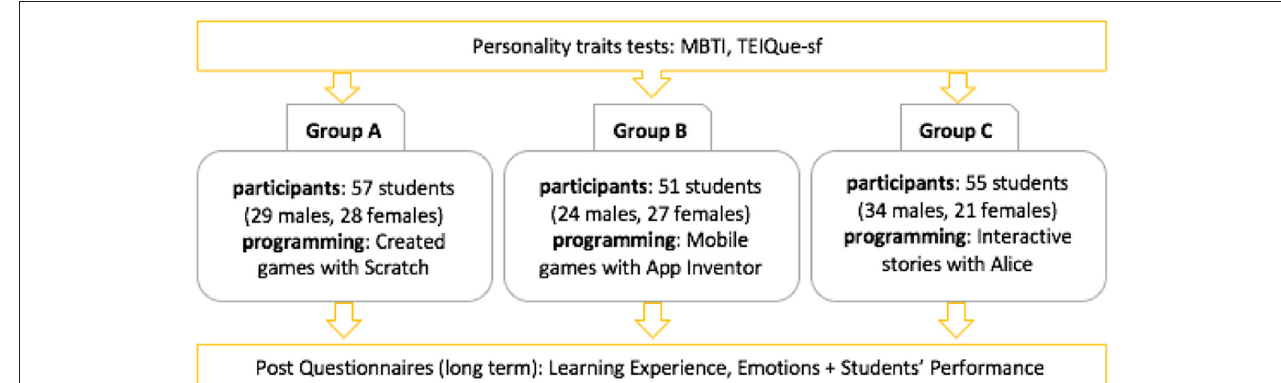
FIGURE 2 | The design of this study.